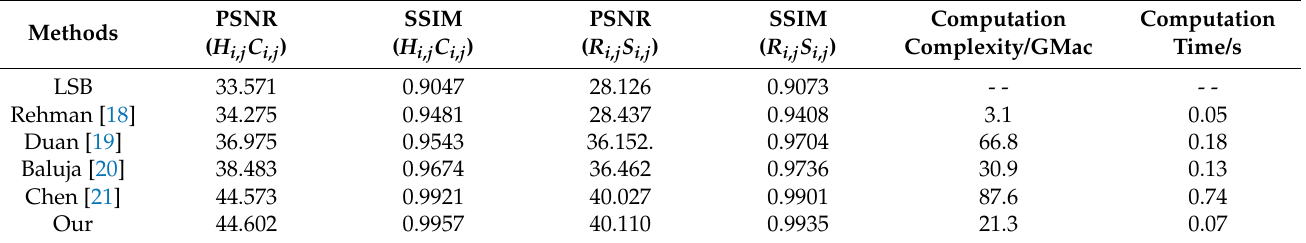
Table 1. Average quantitative indicators of different